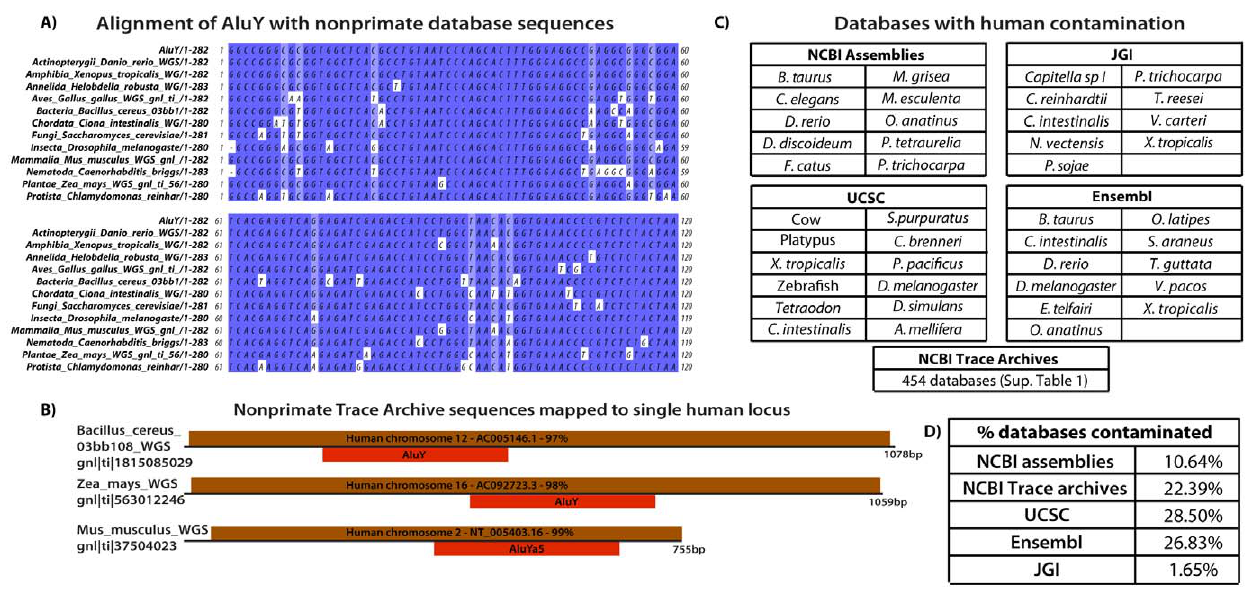
Figure 1. Human sequences found in non-primate databases. A) Representative Clustal alignment of NCBI non-primate trace archive reads to a consensus primate specific AluY. B) Representative NCBI non-primate trace archive reads mapped to single human locus. C) Summary of non- primate databases contaminated with human sequence. D) Percent of public databases identified as contaminated.